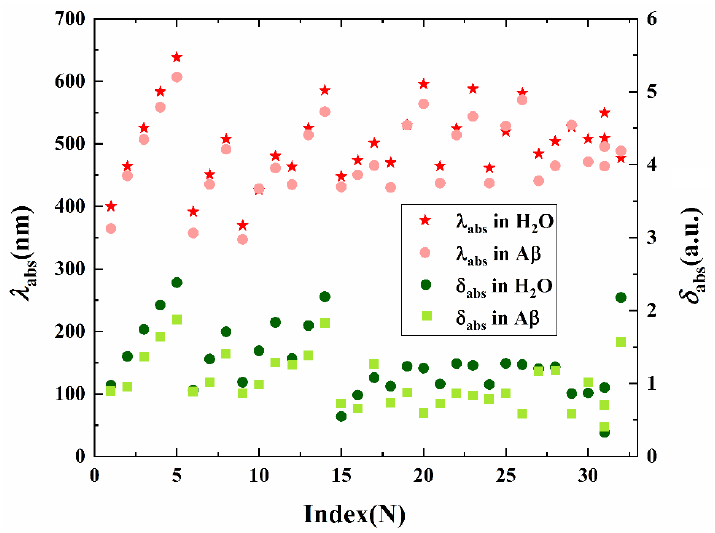
Figure 4. The absorption wavelength λ abs (the left vertical axis) and oscillator strength δ abs (the right vertical axis) for probes 1 – 32 in H 2 O and in A β .